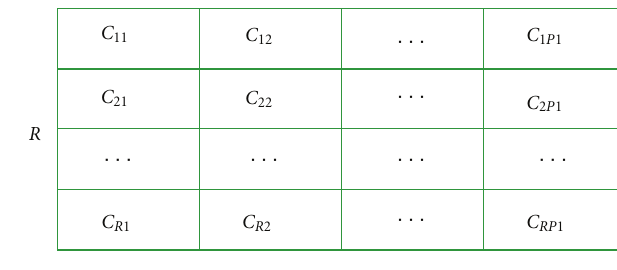
Figure 7: Consequent.